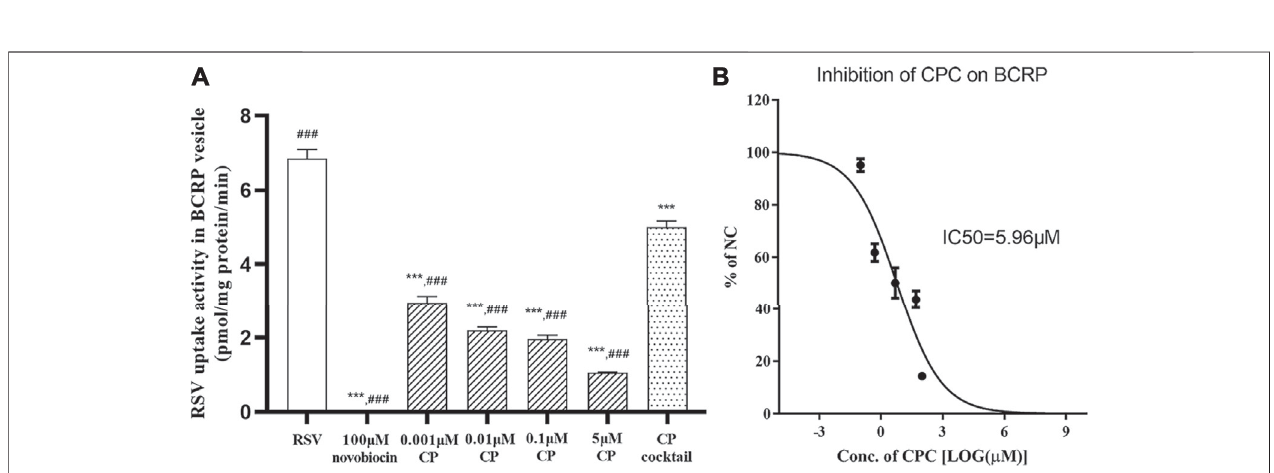
FIGURE 2 | Inhibition of novobiocin, CP, CP cocktail, or CPC on the RSV transport in BCRP-expressing membrane vesicles. The mean uptake activity of RSV by BCRPinthepresenceandabsenceofnovobiocin,CPcocktail(0.001 μ MCPplus2 μ MCPC),andvaryingconcentrationsofCP (A) .Themeanrelativeuptakeactivity(% of NC) of RSV by BCRP with varying concentrations of CPC (B) . Data are presented as the mean ± S.D. (n (cid:2) 4). *** p < 0.001 vs RSV. ### p < 0.001 vs CP cocktail.